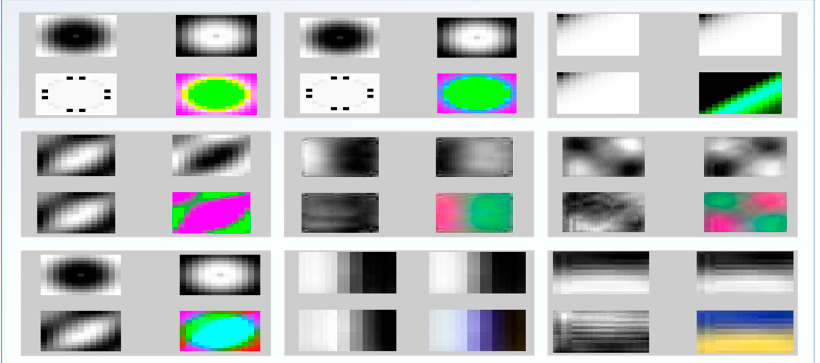
Figure 4. Three-dimensional color Gabor filter convolution kernel.